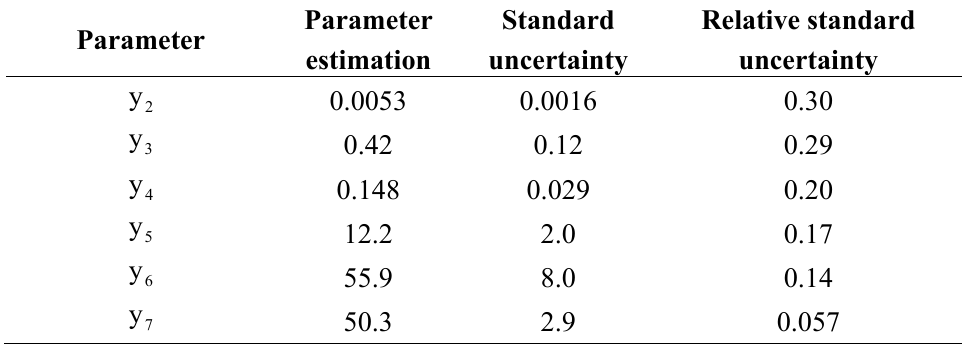
Table 2. Parameter estimation, standard uncertainty and relative standard